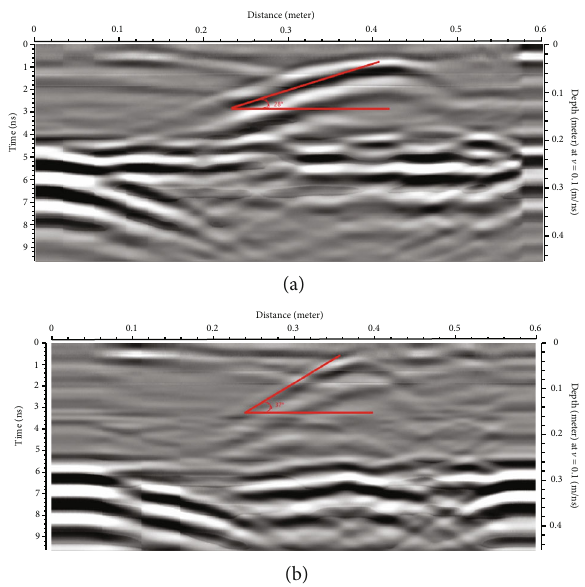
Figure 11: Gray map of radar detection of tubular target with inclination angles of 30 (a) and 45